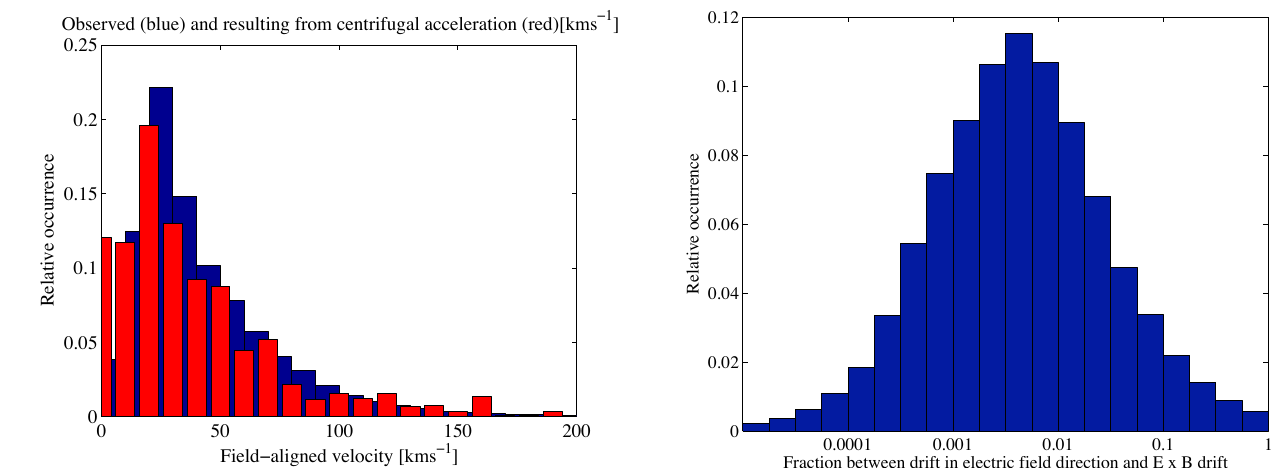
Fig. 9. Distribution of the inertial drift in the direction of the electric field direction as a fraction of the E × B drift velocity. The y-axis shows the relative occurrence.